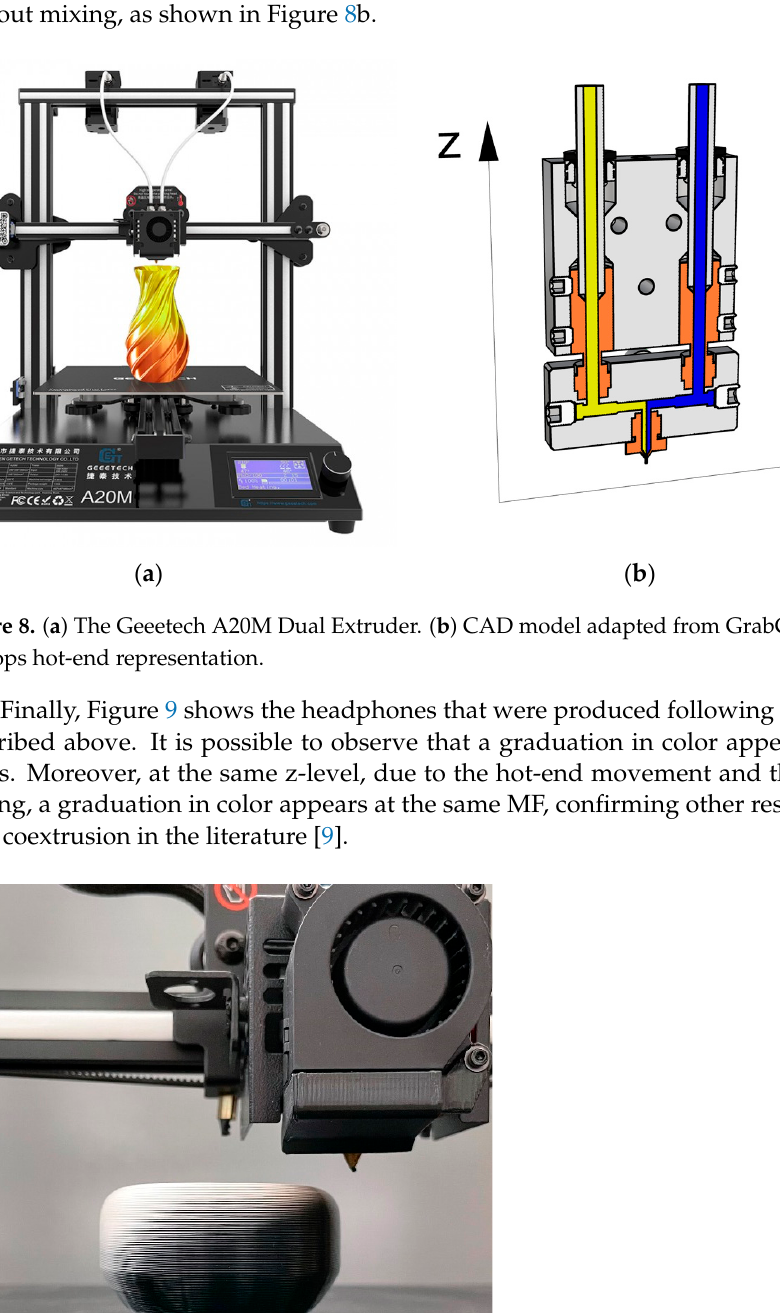
( c ) Figure 7. ( a ) Overlapping of the two ‐ point clouds, i.e., the point cloud of the volumetric information and the point cloud of the path of the tool (the small points). ( b ) Point cloud of the path of the tool with the additional information regarding the material properties visualized with a grade of colors.